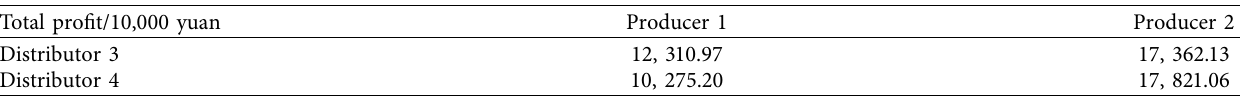
Table 6: Total profits of the producer-distributor subchain through coordinated optimization under the profit-sharing contract after the adjustment of cost functions.